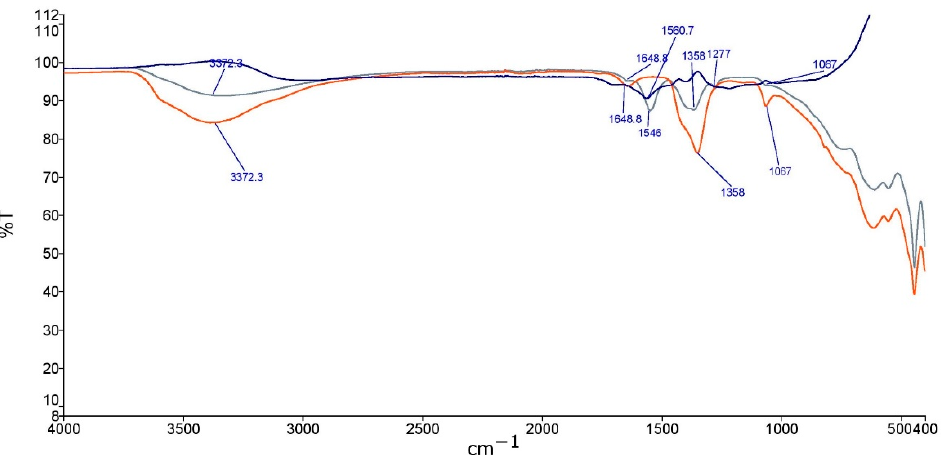
Figure 1. FTIR spectra of bare LDH (red spectrum), GQDs (blue spectrum), and LDH/GQDs composite (green spectrum).